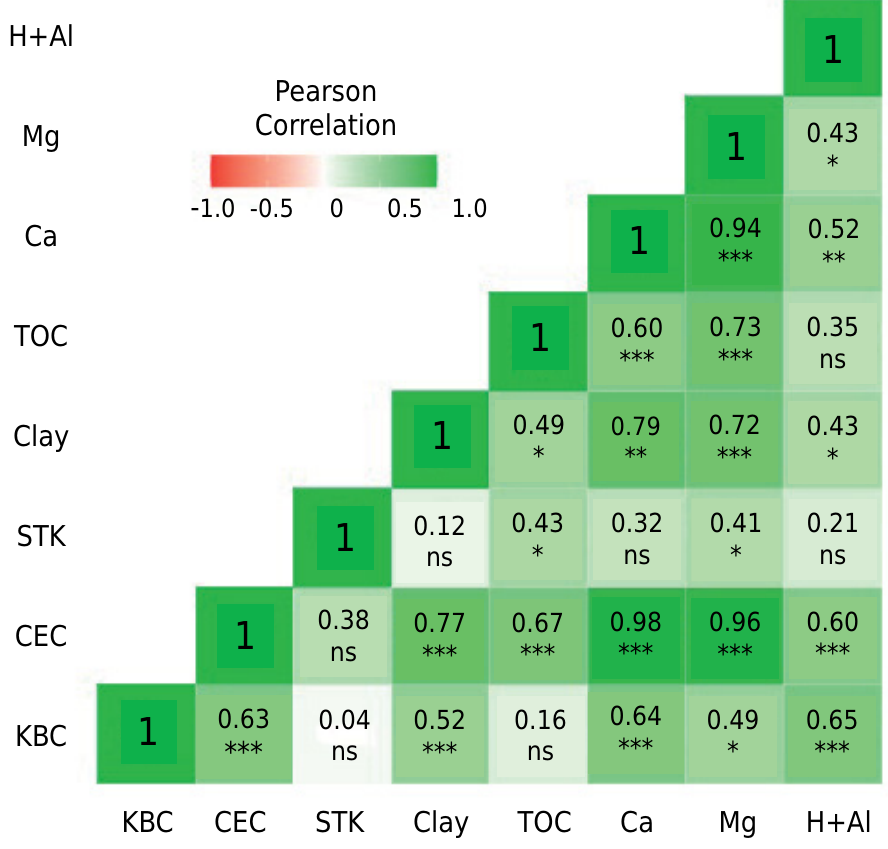
Figure 3. Pearson correlation values and significance between the variables of 23 soil samples representative of the Rio Grande do Sul and Santa Catarina states. KBC: potassium buffering capacity; CEC: cation exchangeable capacity; STK: soil test potassium; clay: clay content; TOC: total organic carbon; Ca: exchangeable calcium content; Mg: exchangeable magnesium content; H+Al: potential acidity; ns: no significative; * significative at 5 %; ** significative at 1 %; and *** significative at 0.1